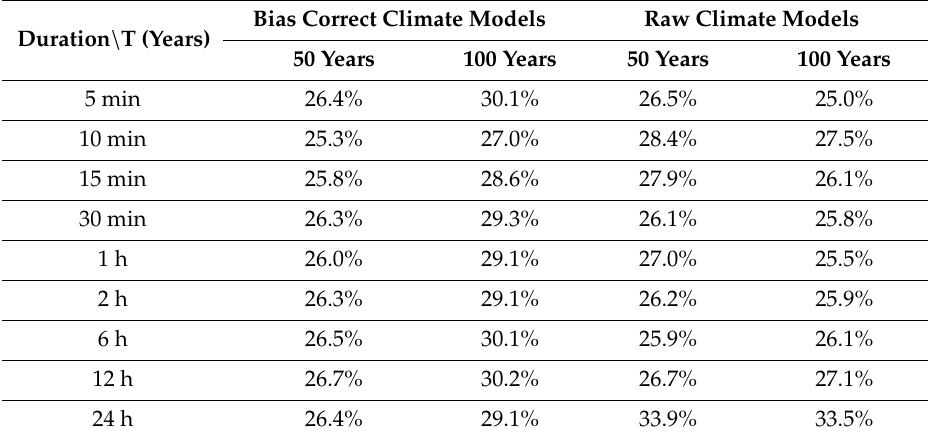
Table 1. Projection (%) for London CS station, for RCP 8.5, period 2071–2100 using bias-corrected models, using the 50th of the multi-model